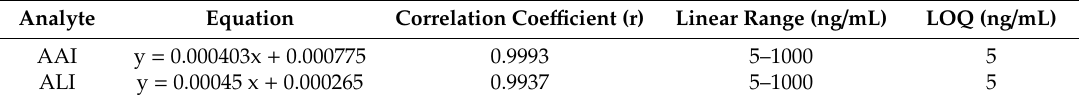
Table 4. Linearity, LOQ of the LC-MS / MS assay for AAI and ALI in liver. Analyte Equation